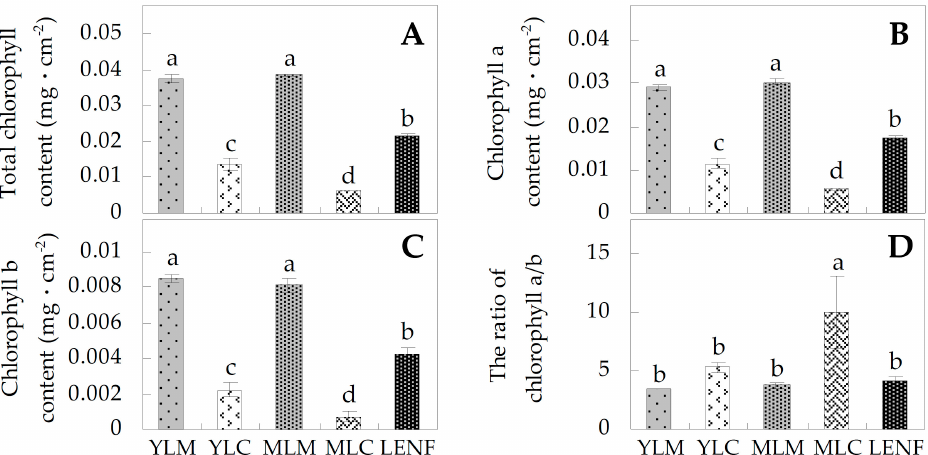
Figure 3. Chlorophyll contents of various leaf regions at different development stages of Hosta “Gold Standard”. ( A ) Total chlorophyll content; ( B ) chlorophyll a content; ( C ) chlorophyll b content; ( D ) the ratio of chlorophyll a / b . The values were determined in young leaf margin (YLM), young leaf center (YLC), mature leaf margin (MLM), mature leaf center (MLC), and leaf under excess nitrogen fertilization (LENF), which were presented as means ± SE ( n = 3). The different small letters on the columns indicate significant differences among various leaf regions at different development stages ( p < 0.05).